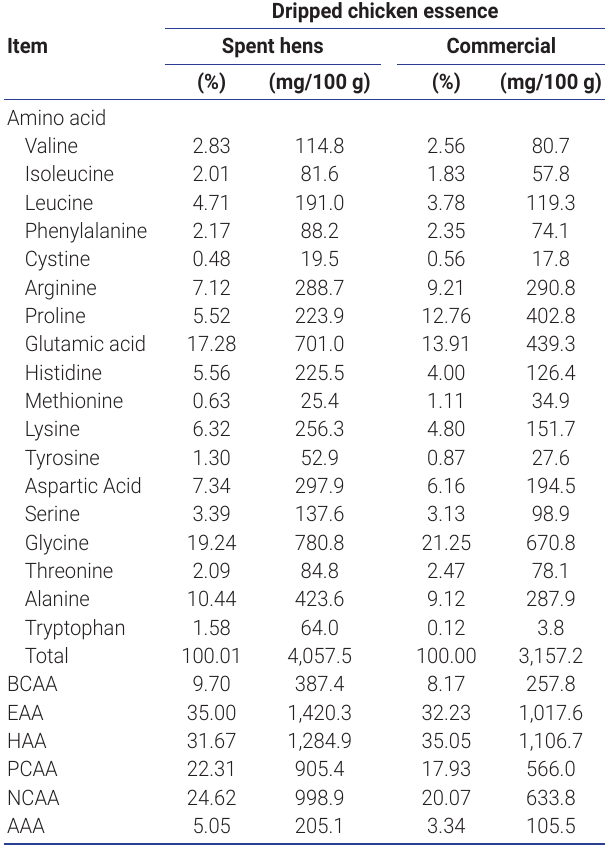
Table 1. Amino acid composition of spent hens and commercial dripped chicken essence Dripped chicken essence Spent Item